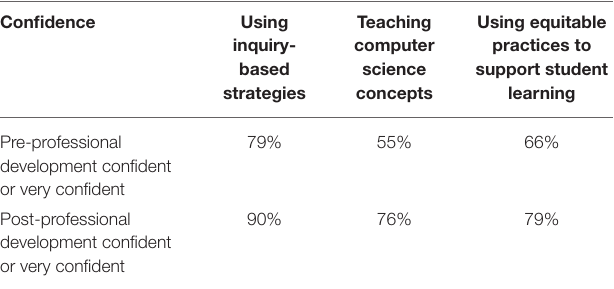
TABLE 1 | Teachers’ confidence as reported in pre- and post-professional development surveys.